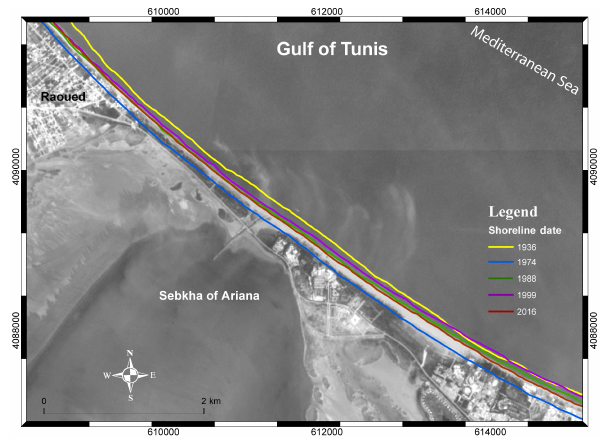
Figure 10. Multitemporal shoreline evolution of